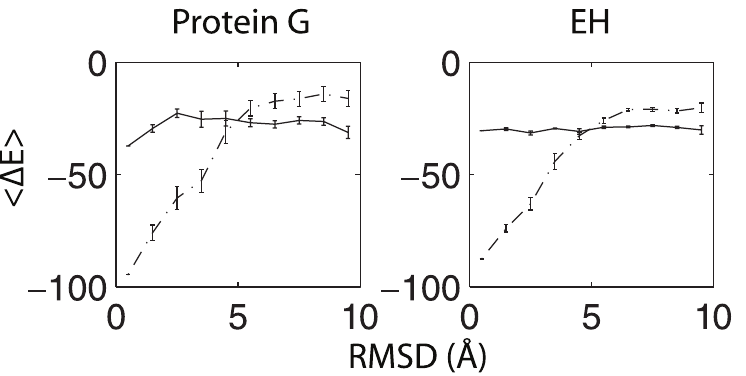
Figure 6. Relative magnitude of the average hydrogen bonding energy (solid line) versus the total average energy (dash-dot line) as a function of C a RMSD for protein G and engrailed homeodomain (EH).